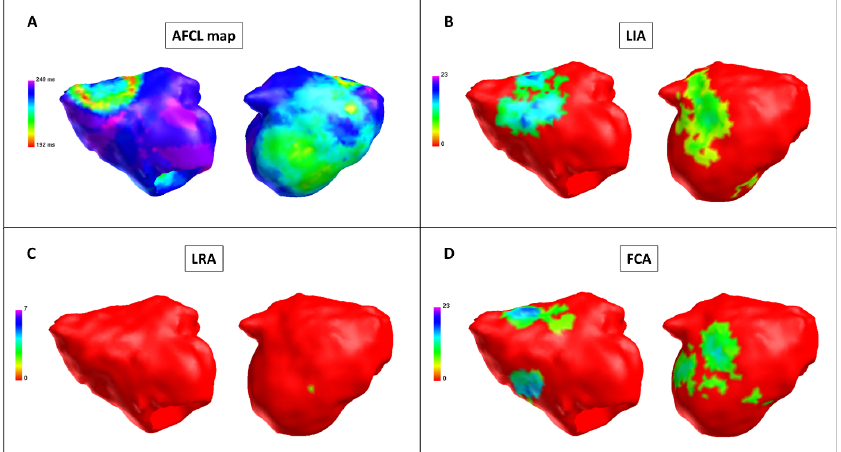
Figure 3. Charge density map after posterior wall isolation (Patient 9). Charge density map with the AcQmap TM catheter after pulmonary vein isolation (PVI) + left atrial posterior wall isolation (LAPWI). Each color point on the map corresponds to the color-matched legend on the left. ( Panel A ) Atrial fibrillation cycle length (AFCL) map: left side, anterior-posterior view; right side, posterior-anterior view. When compared with the baseline and post-PVI maps, the AFCL is higher, especially in the roof and posterior regions. Color bar describes AFCL in ms. ( Panel B ) LIA map: left side, anterior-posterior view; right side, posterior-anterior view. After PVI + LAPWI, there is a significant reduction in LIA in the inferior region. Color bar describes LIA in LIA/s. ( Panel C ) LRA map: left side, anterior-posterior view; right side, posterior-anterior view. After PVI + LAPWI, there is a significant reduction in LRA in the inferior region. Color bar describes LRA in LRA/s. ( Panel D ) FCA map: left side, anterior-posterior view; right side, posterior-anterior view. Higher FCA number in the anterior and posterior regions with no significant change after PVI + LAPWI. Color bar describes FCA in FCA/s. FCA: focal centrifugal activation; LIA: localized irregular activation; LRA: localized rotational activation. Table 3. Charge density map data pre- and post-posterior wall isolation.